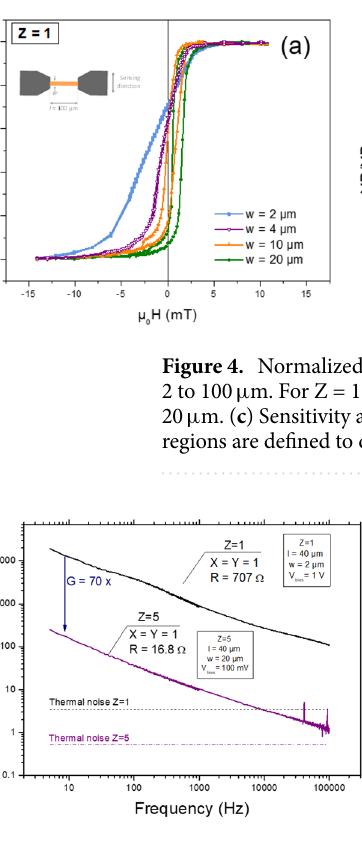
Figure 5. ( a ) Noise curves for a single Z = 1 and Z = 5 packed spin-valves, measured at the most sensitive point of the curve ( H app = 0 ). The two dashed lines indicate the calculated thermal noise baseline. The bias voltage was calculated in order to have about 1 mA flowing per each spin-valve. ( b ) Detectivity curves obtained through the ratio between noise and sensitivity for four devices (Device A, B, C, D in Table 2) with different number of sensors. Device A was biased with 1 V and the others with 3 V. ( c ) Output of Device D under a bias voltage of 3 V, in an unshielded environment and subjected to variable voltage amplitude applied to the external coil at 35 Hz. The inset shows R(H) of Device D with MR = 6.3%, R min = 10 k (cid:31) , µ 0 H off = 0.2 mT, µ 0 H c = 0.25 mT and a zero field sensitivity of 1.7%/mT (or 17.2